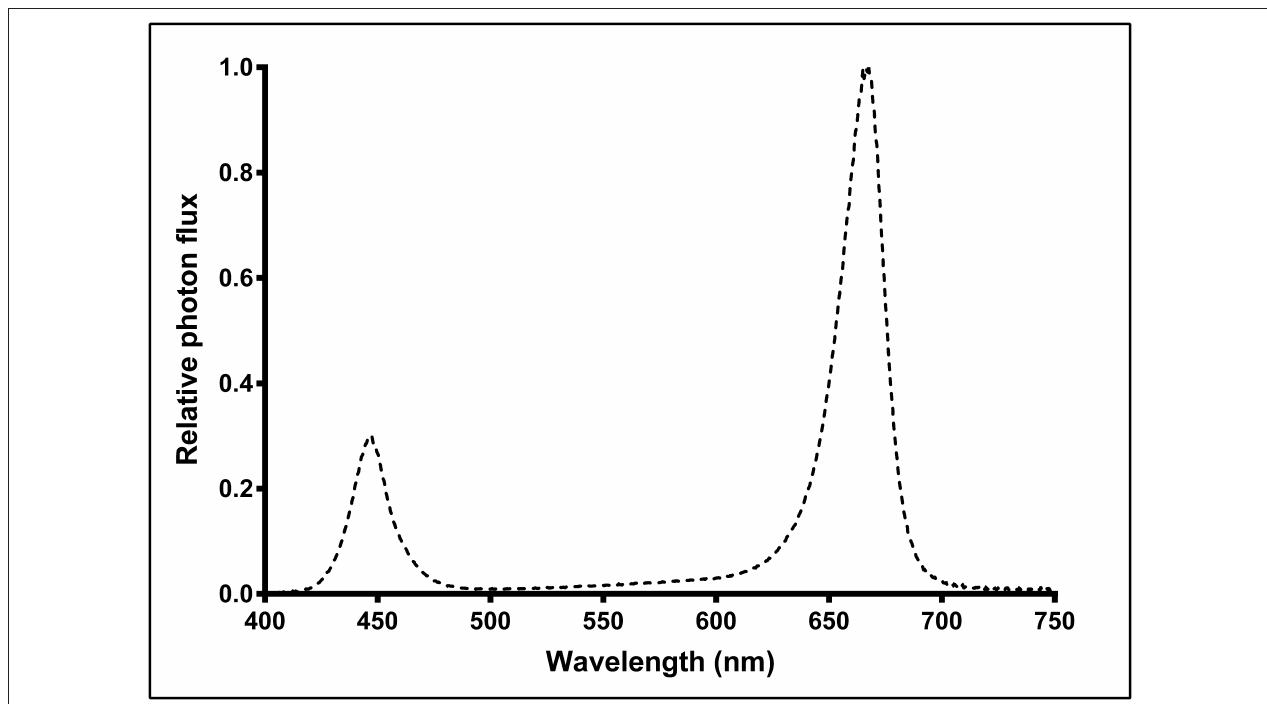
FIGURE 1 | Relative spectral photon flux distribution of Pro-650 (Lumigrow) light-emitting diode (LED)